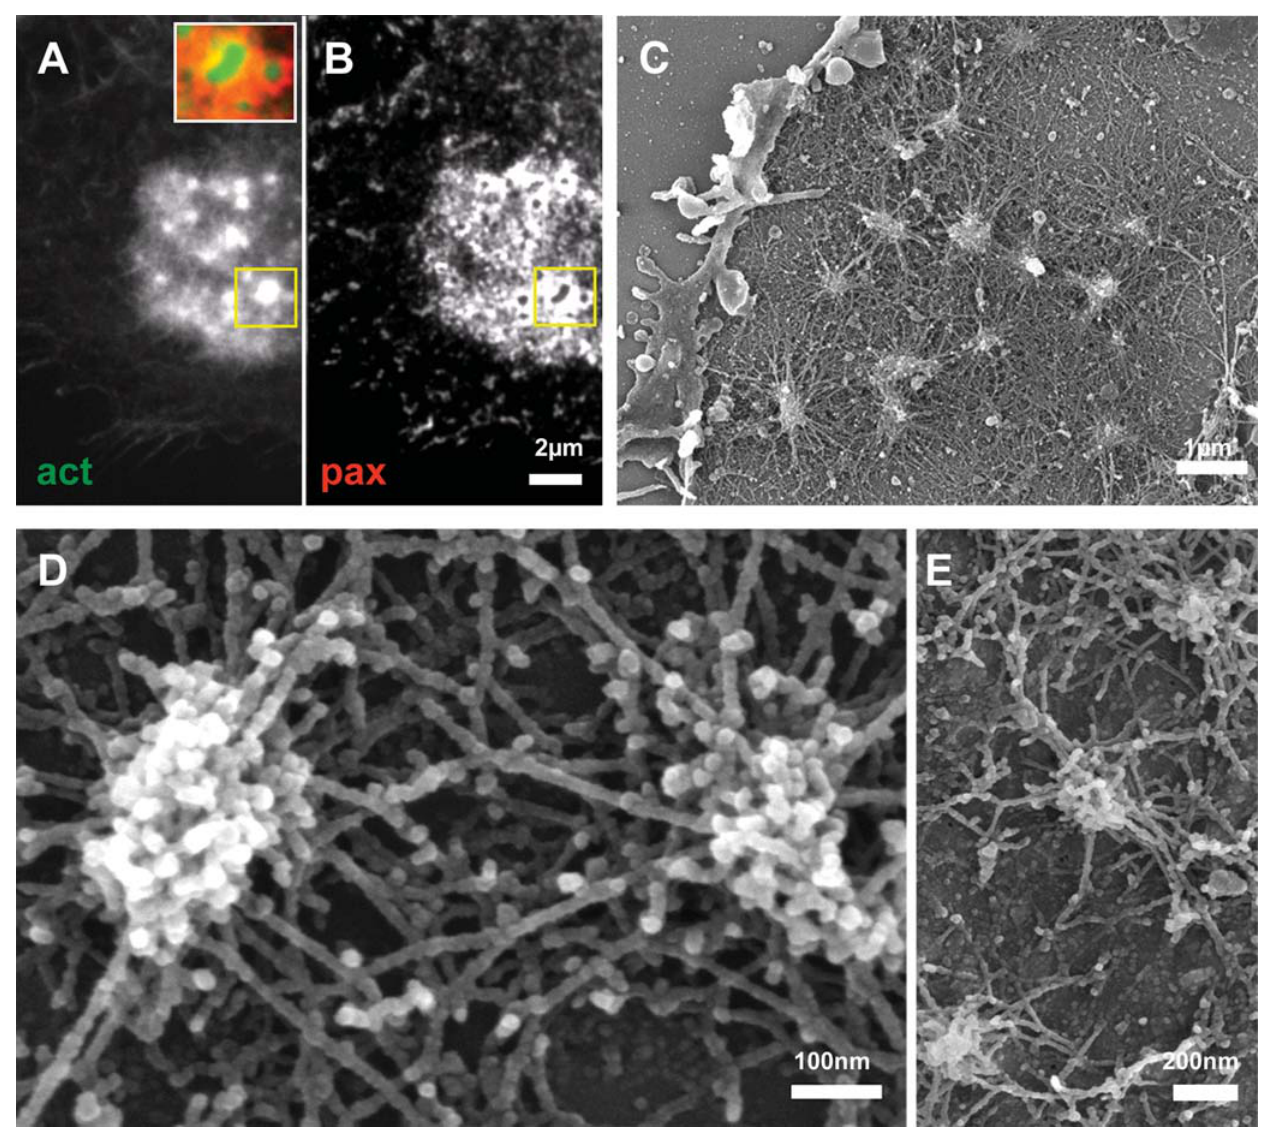
Figure 2. Clustered podosomes. Intact osteoclast (A,B) or ventral membranes (C–E) fixed and stained for actin (A) or paxillin (B) or prepared for HR- SEM (C–E). (A) Actin pillars emanate from an ‘‘actin-cloud’’. (B) Paxillin is largely shared by the cluster and overlaps with the ‘‘actin-cloud’’. The insert in (A) shows a merged image of actin/paxillin staining. (C) SEM over-view of a cluster. The radial podosome actin fibers appear to correspond to the ‘‘actin-cloud’’. (D) Higher magnification view of two clustered podosomes showing interactions between radial peripheral cables. There are no cables directly connecting between cores. (E) The same organization as in (D) is detected on bone.